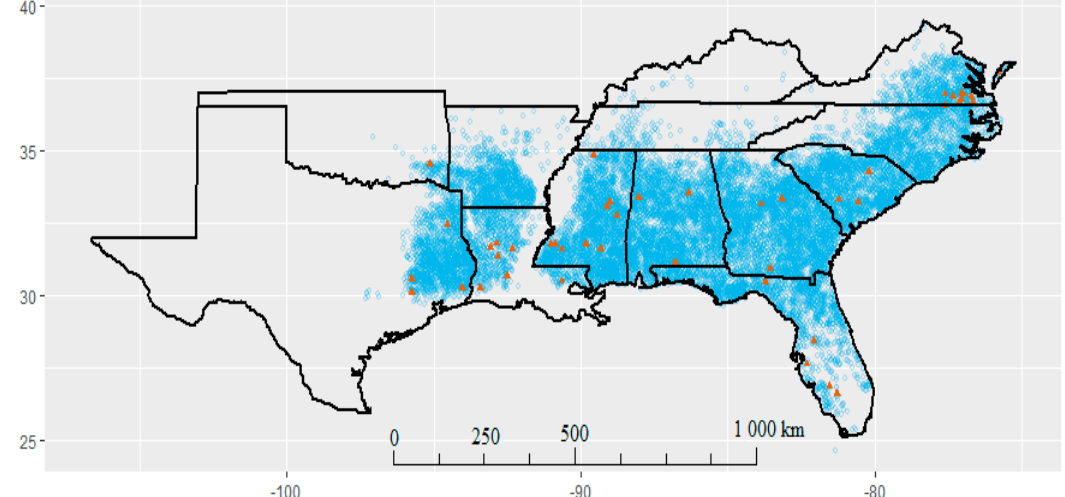
Figure 1. Distribution of Forest Inventory and Analysis (FIA) plots used in the study; plots with no foliar disease are represented with blue circles and those with incidences of foliar disease are represented with red